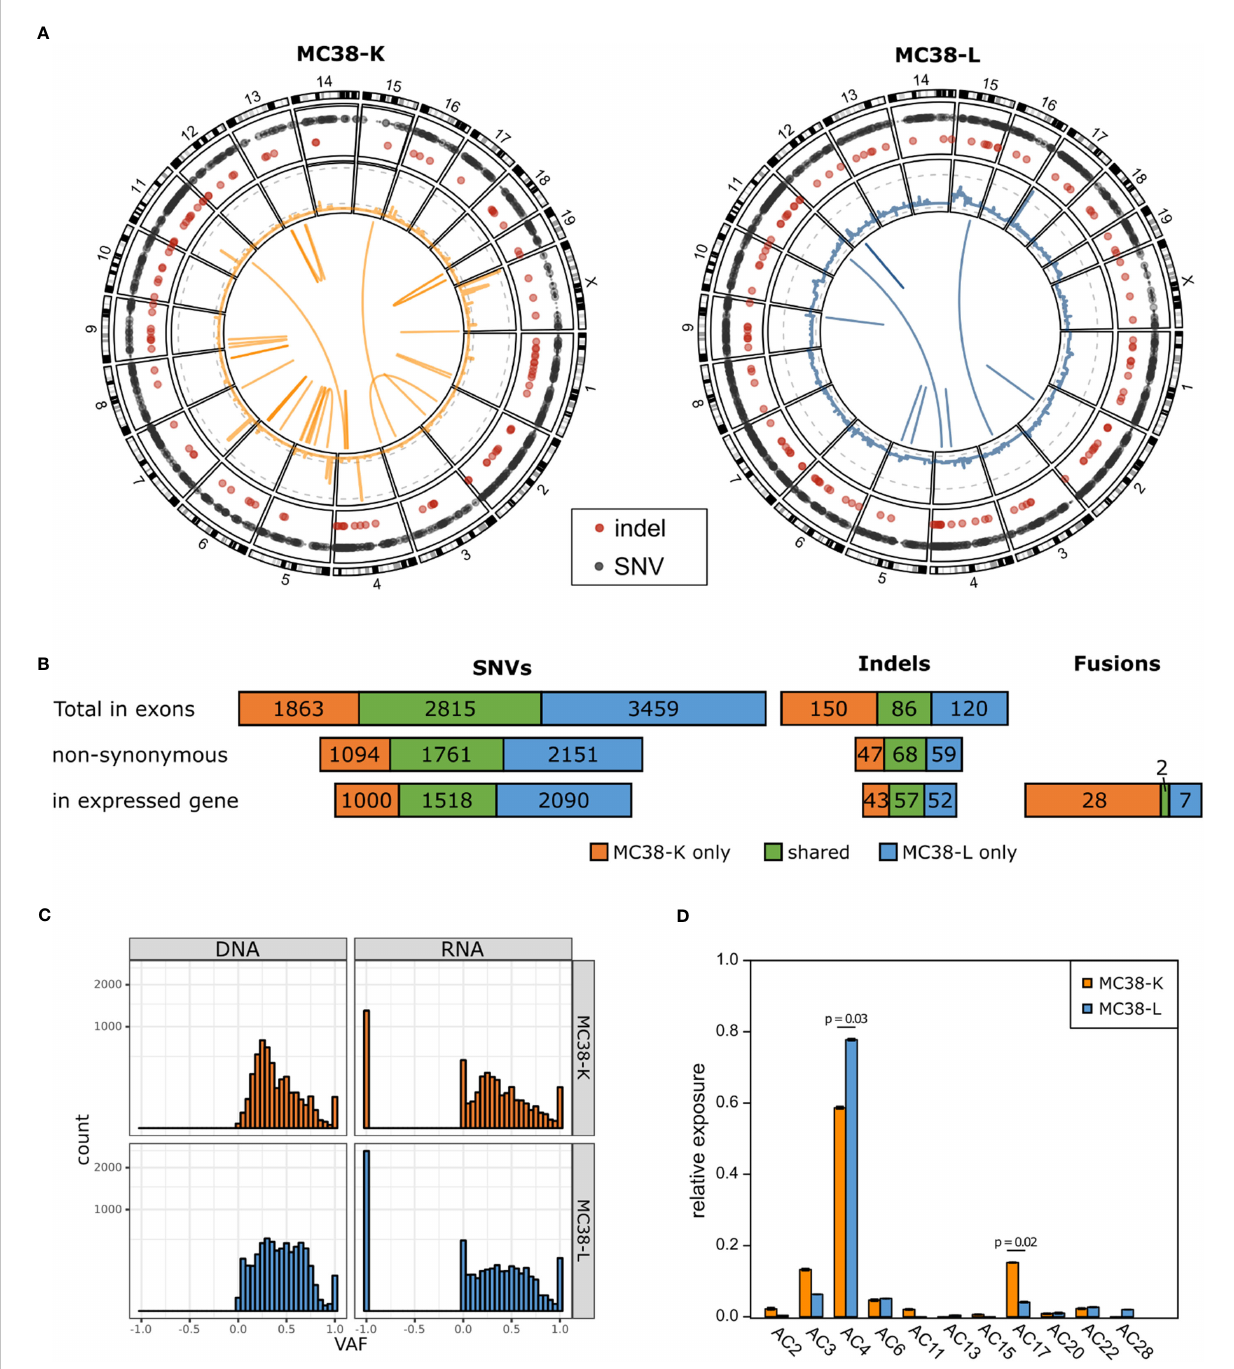
FIGURE 1 MC38 cell lines MC38-K and MC38-L differ substantially on genomic level. (A) Circos plots showing the somatic alterations of both cell lines compared to wild type C57BL/6 mice. Outer circle: SNVs (grey) and small indels (red); second circle from the outside: CNVs, log scaled, with grey dashed lines marking copy numbers 1, 25 and 200 (MC38-K only); middle: fusion gene events. (B) Number of SNVs, indels and fusion gene events detected in MC38-K or MC38-L only or shared by both cell lines. (C) Variant allele frequencies (VAF) distributions of SNVs in exons in DNA and RNA of both cell lines. VAF values of -1 indicate no coverage in RNA-seq. (D) Mutational signatures observed in both cell lines. Signi fi cant differences (adjusted p-value < 0.05) are indicated with a line and the respective p-values are depicted. Signi fi cance was determined with t-test followed by multiple testing correction with Benjamini-Hochberg